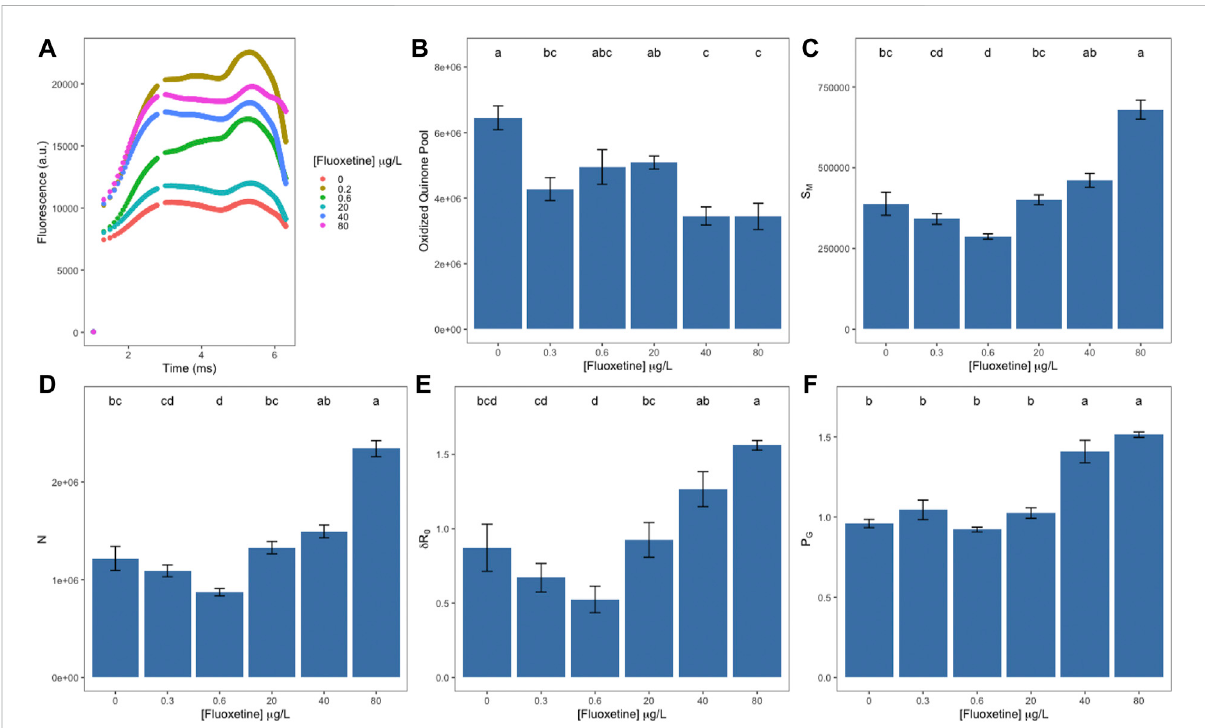
FIGURE 1 OJIP-derived parameters of Ulva lactuca following a 48-h exposure to different fl uoxetine concentrations. (A) Kautsky chlorophyll a fl uorescenceinductioncurves. (B) Oxidizedquinonepool. (C) Energyneededtocloseallreactioncentres(SM). (D) Reactioncentreturnoverrate(N). (E) Probability of moving an electron from quinone B (QB) to the PSI end-electron acceptor ( δ R0). (F) Grouping probability (PG). Average ± standard error, N = 5; different letters indicate signi fi cant differences at p <